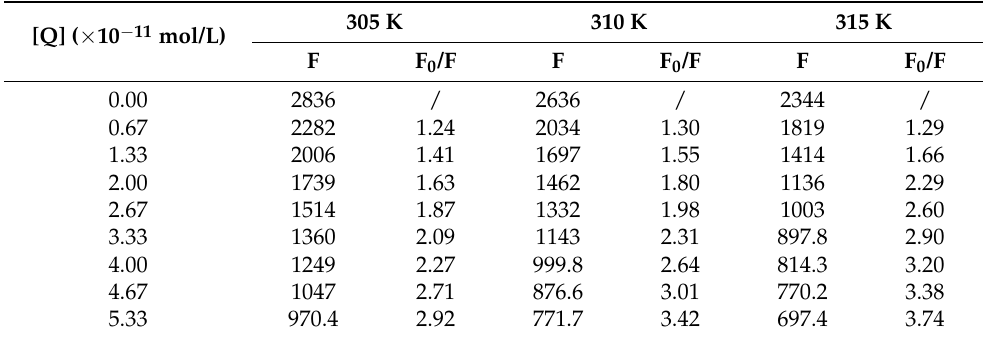
Figure 7. The fluorescence quenching of MAO-B by LB. ( A ). The fluorescence emission spectra of MAO-B-LB with an excitation wavelength of 280 nm, a → i were the fluorescence spectra with 0 → 8 µ L LB added, ( B ). 3D fluorescence spectra of MAO-B, ( C ). 3D fluorescence spectra of MAO-B-LB.). According to the fluorescence spectra obtained after adding different concentrations of The Stern–Volmer curves of the fluorescence quenching of MAO-B by LB at different LB at different temperatures (305 K, 310 K and 315 K), the fluorescence intensity of MAO-B temperatures are displayed in Figure 8, and the quenching constant, K sv and correlation before and after adding LB was recorded as F0 and F, respectively, and F0/F was calculated. coefficient of MAO-B obtained by the linear equation are shown in Table 5. It was found The specific data are listed in Table 4. that the K sv increased as temperature increased. Kq values were 2.79 × 10 10 , 3.38 × 10 10 and 4.55 × 10 12 L/( mol·s) at 305, 310 and 315 K, respectively, and these values were almost Table 4. The fluorescence intensity at different temperatures of LB before and after the addition of equal to the maximum quenching rate constants of the biomolecule (2.0 × 10 10 L/(mol·s)) [32]. All of these results demonstrated that the fluorescence quenching of MAO-B by LB was dynamic quenching, which caused the reaction between the quenching agent and the fluorescent material molecules in the ground state.